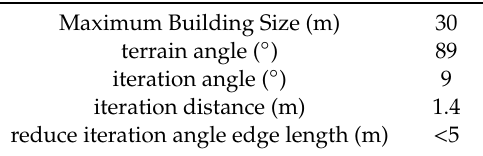
Table 2. Ground classification processing